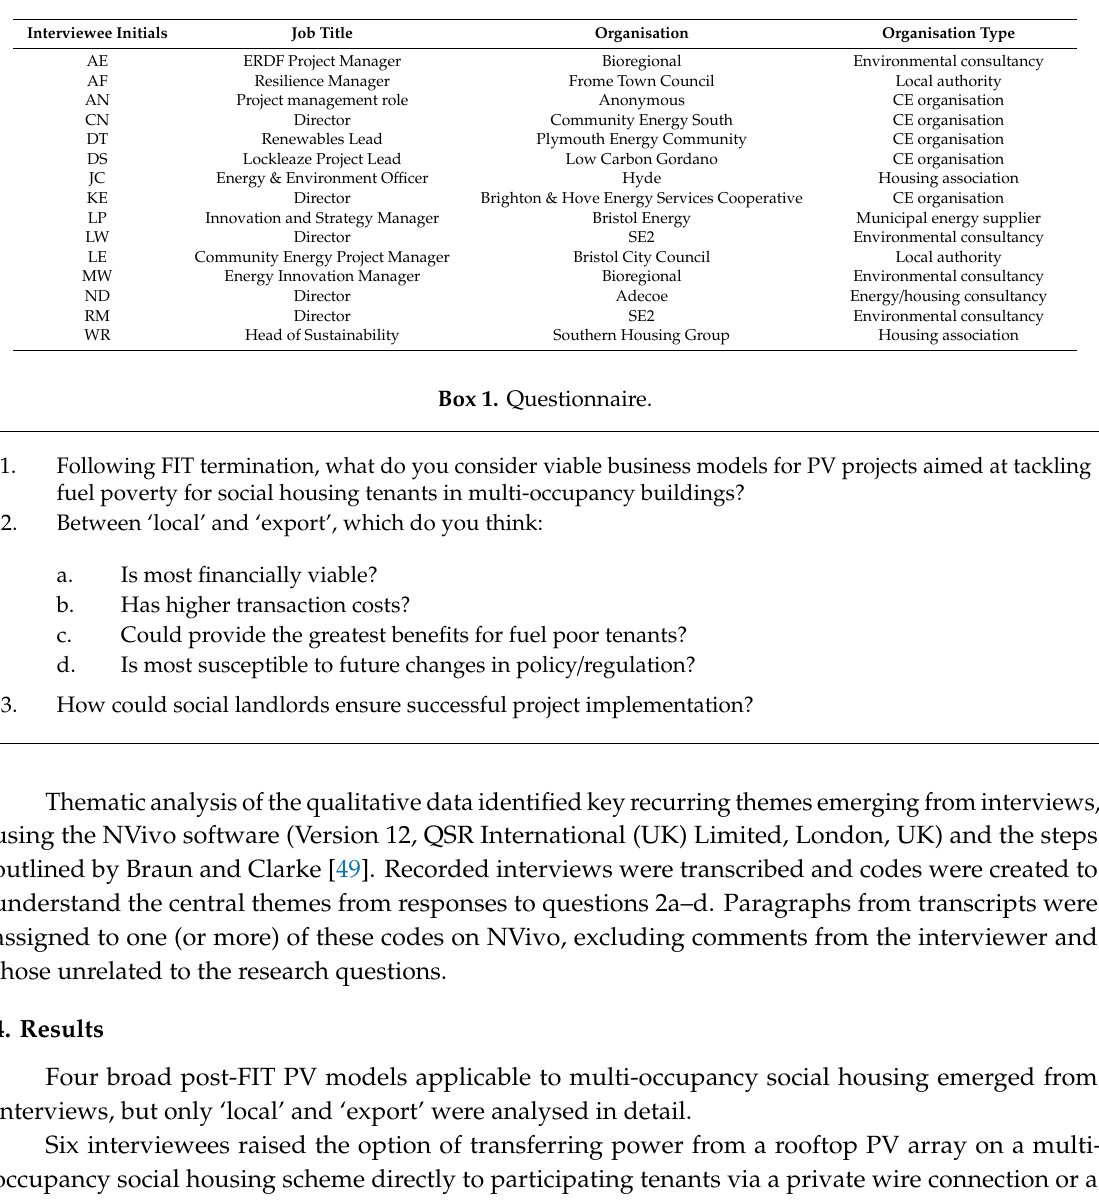
Table 2. Interviewee